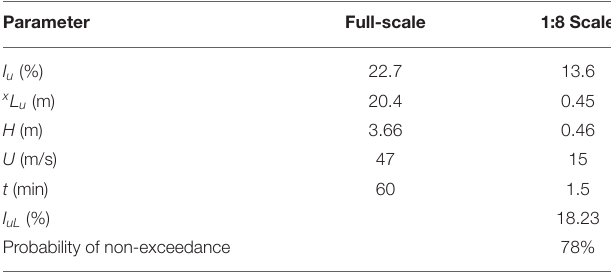
TABLE 1 | Comparison of flow parameters between model and prototype.